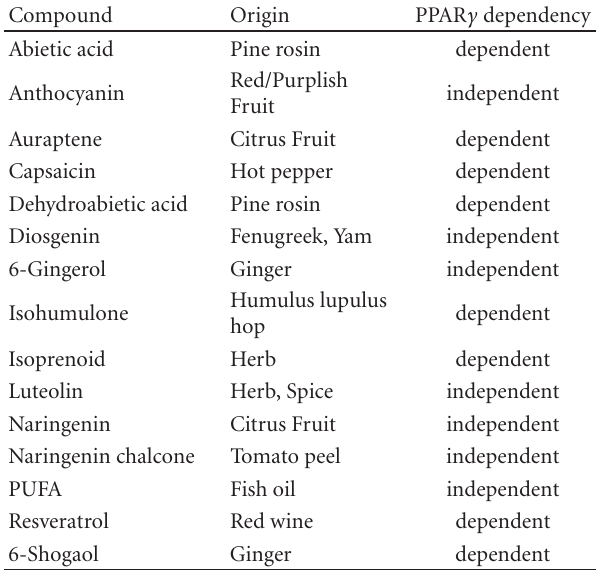
Table 1: Phytochemicals that regulate obesity-induced inflamma-